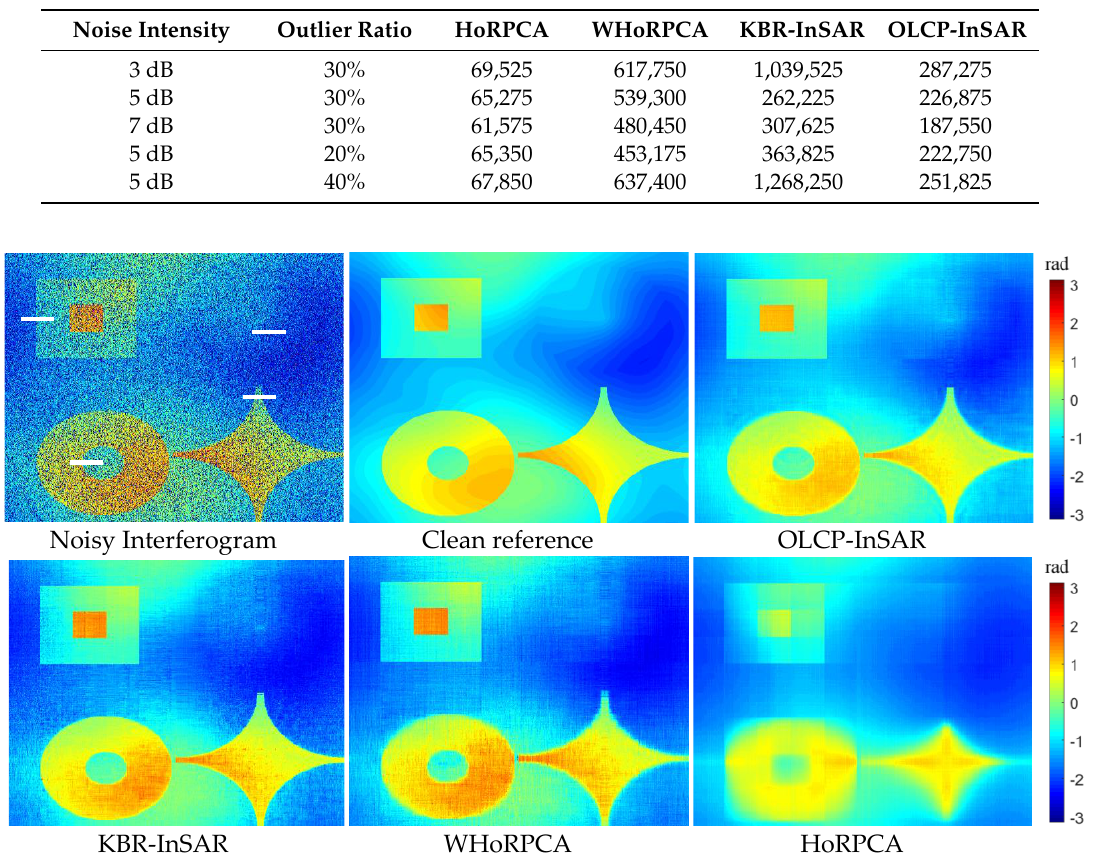
Table 2. The number of remaining residues of filtered tensors with different noise conditions.